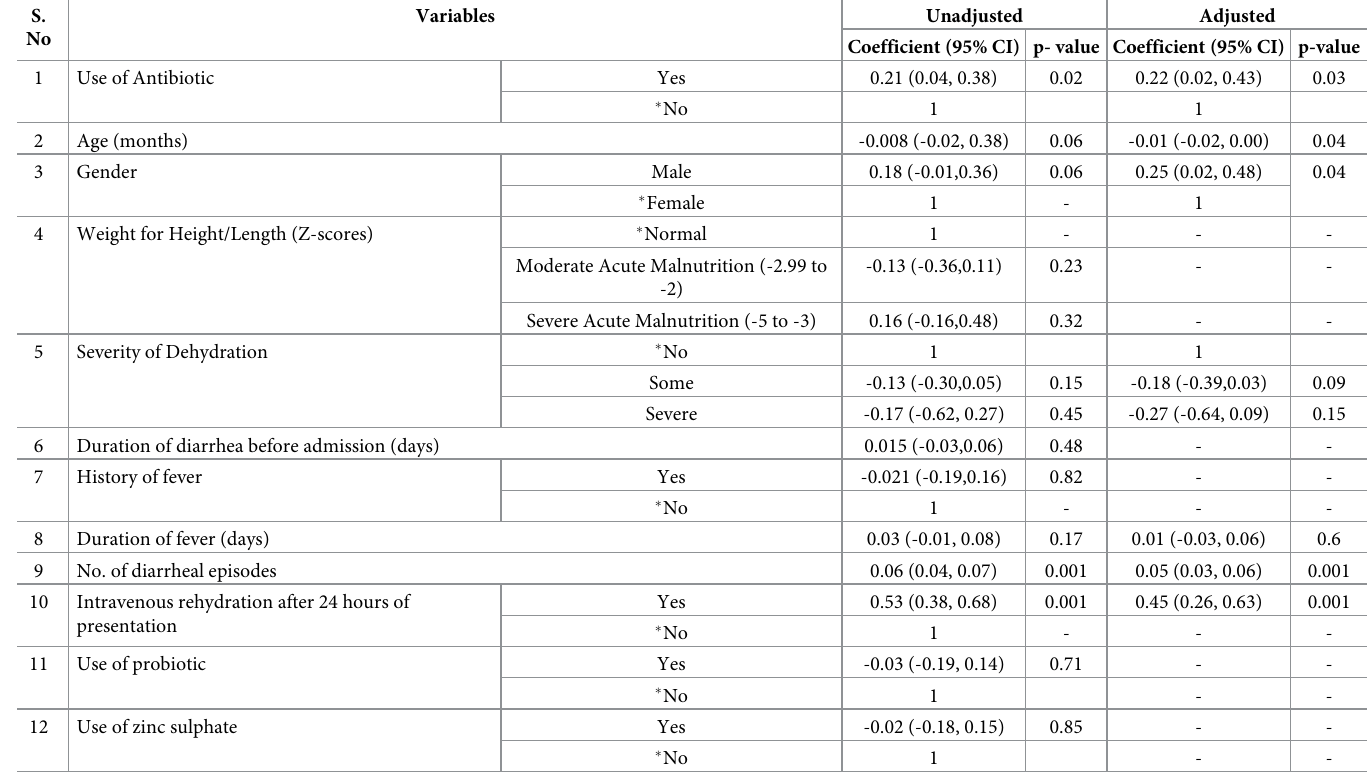
Table 2. Unadjusted and adjusted analysis of clinical characteristics and length of hospital stay (hours) in children presented with acute watery diarrhea in a ter- tiary care